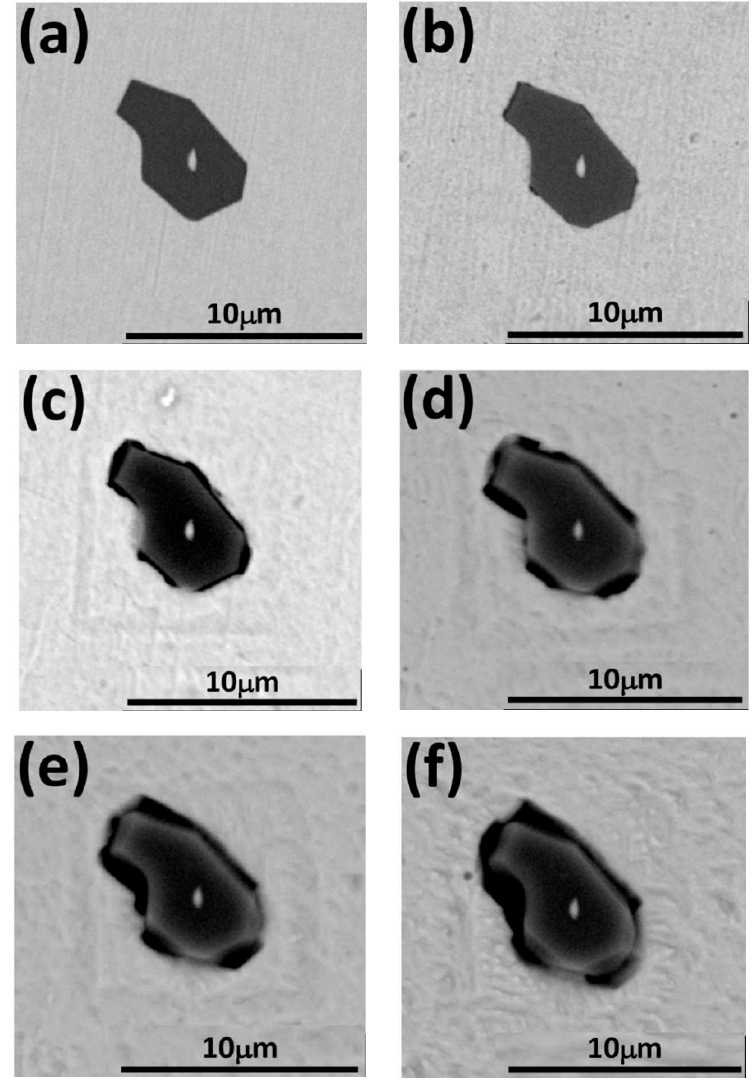
Figure 7. Morphology observation of singly distributed Al 2 O 3 inclusions. ( a ) 0 s; ( b ) 15 s; ( c ) 35 s; ( d ) 65 s; ( e ) 105 s; and ( f ) 155 s.